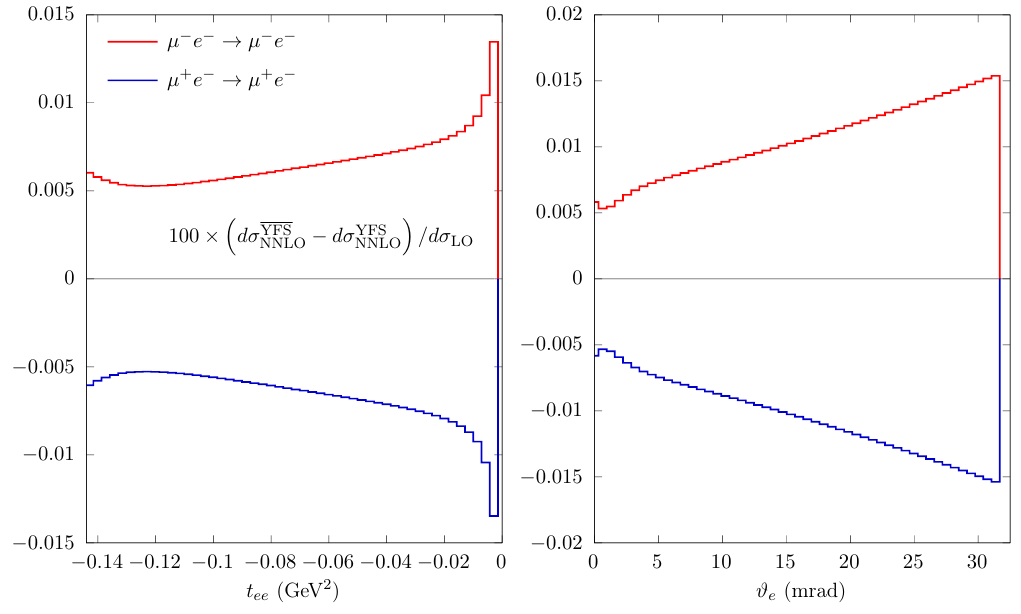
Figure 12 . Di(cid:11)erence between the alternative implementation of the YFS approximation de- scribed at the end of section 4.2 and the standard one, as a function of the t ee (left) and # e (right)